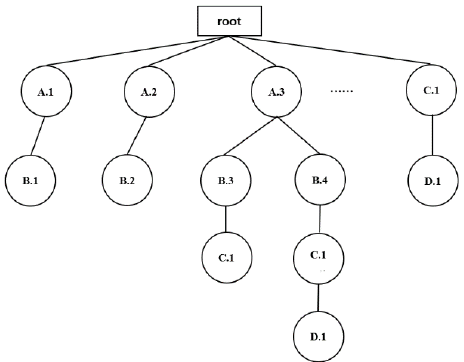
Figure 7. An example of an N-tree constructed by the NDM.